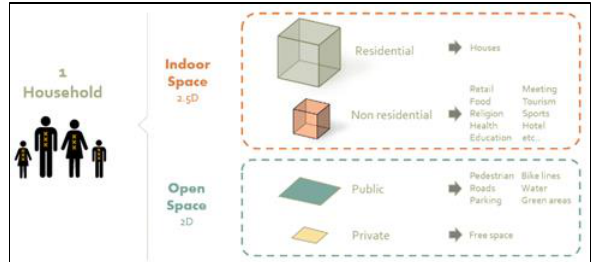
Figure 3. Elements to consider in space